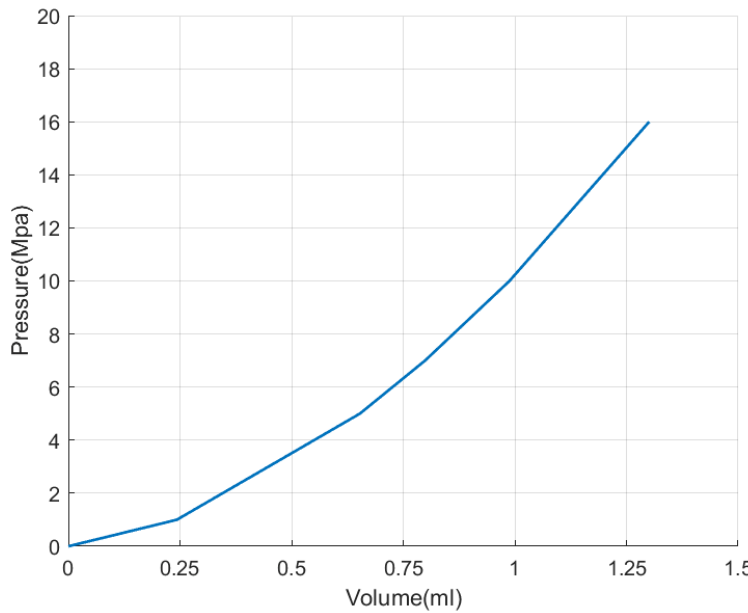
Figure 9. P-V characteristic of rear wheel brake.